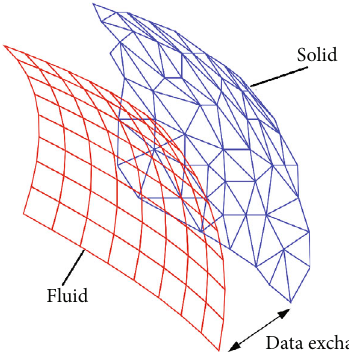
Figure 3: Data transfer of unmatched grids.